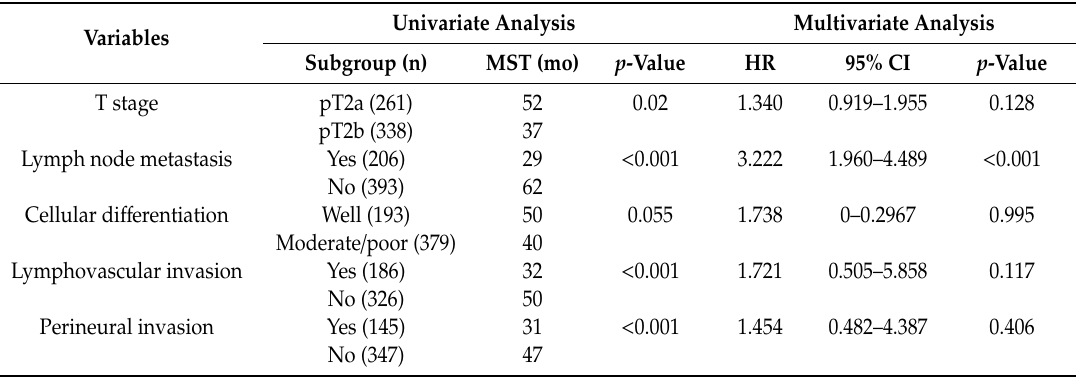
Table 3. Multivariate analysis using the Cox regression proportional hazard model for disease specific survival in T2